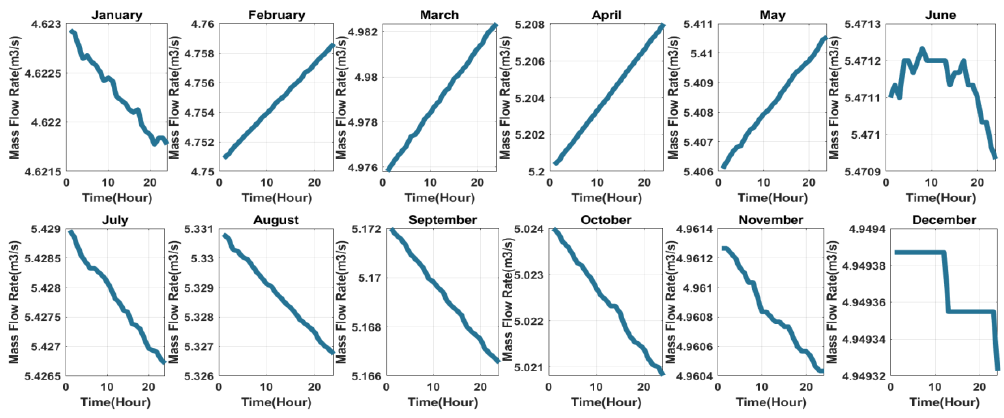
Figure 10. Mass flow rate.